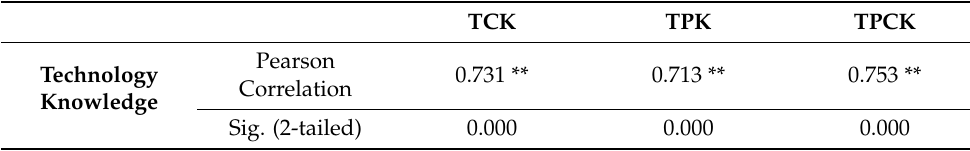
Table 7. Correlation between the TCK, TPK, and TPCK Constructs and the TK Construct. TCK TPK TPCK